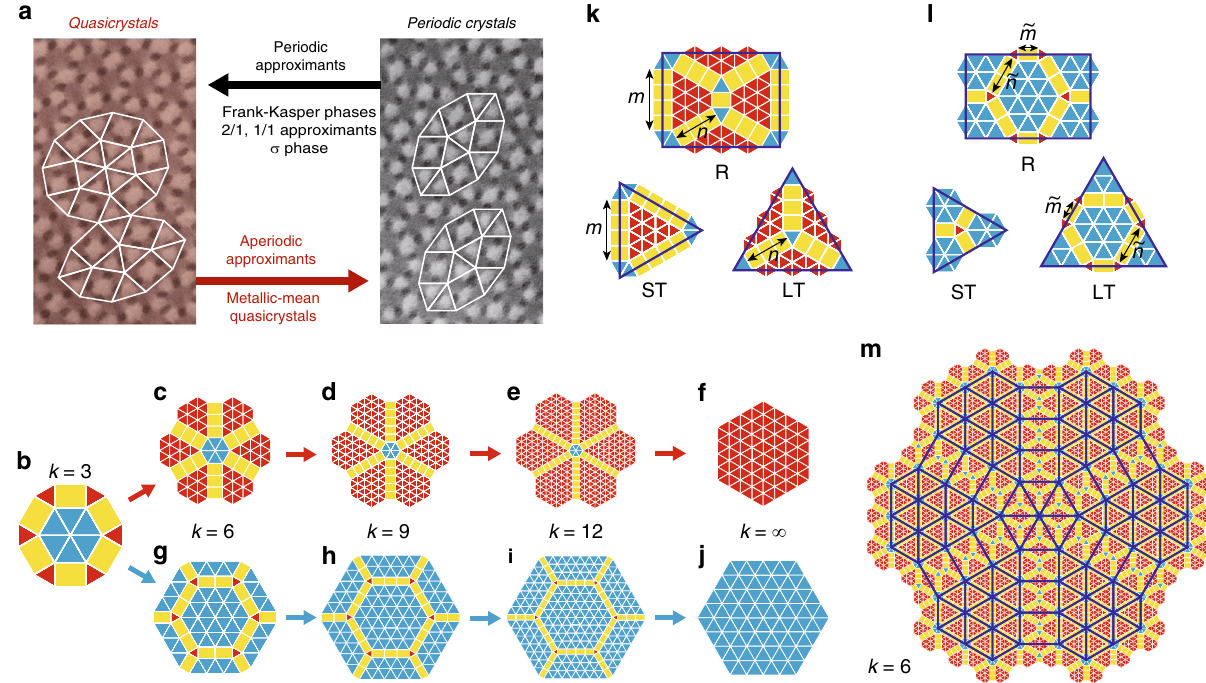
Fig. 1 Metallic-mean aperiodic approximants. a Schematic showing the role of aperiodic approximants as a link between QCs and periodic crystals illustrated by bright- fi eld transmission electron micrographs of dodecagonal QCs and (3 2 .4.3.4) Archimedean tiling observed in star terpolymer- homopolymer blend used in ref. 17 ; the latter consists exclusively of the rugby-ball local motifs (outline) whereas the former features various local motifs including the dodecagonal wheel. b First-generation bronze-mean k = 3 ( n = 1, m = 1) tiling. c – f First-generation type IA tilings with k = 6 ( n = 3, m = 4), k = 9 ( n = 5, m = 7), k = 12 ( n = 7, m = 10), and k → ∞ , respectively. g – j First-generation type IB tilings with k ¼ 6 ð ~ n ¼ 2 ; ~ m ¼ 1 Þ , k ¼ 9 ð ~ n ¼ 3 ; ~ m ¼ 2 Þ , k ¼ 12 ð ~ n ¼ 4 ; ~ m ¼ 3 Þ , and k → ∞ , respectively. In f , j the k → ∞ patterns are drawn schematically, showing only a patch of majority tiles. k , l Subdivision patterns for the rectangle (R), small triangle (ST), and large triangle (LT) tiles in k = 6 type IA and IB tilings, respectively, which also illustrate the meaning of n ; m ; ~ n , and ~ m . m Second-generation k = 6 type IA tiling, with dark blue outlines showing the superimposed fi rst-generation tiling magni fi ed by a factor of